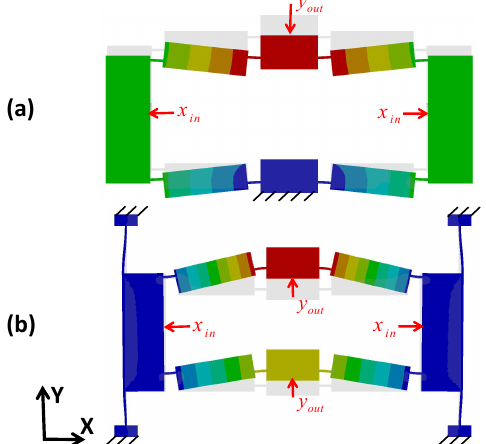
Figure 2. Schematic of ( a ) the BTAM, and ( b ) the improved bridge-type mechanism.